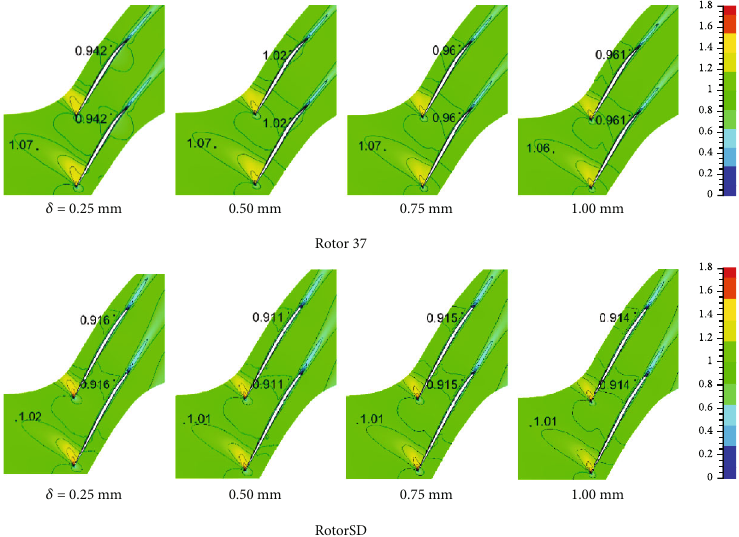
Figure 19: Contours of the relative Mach number at 70% of the design speed.